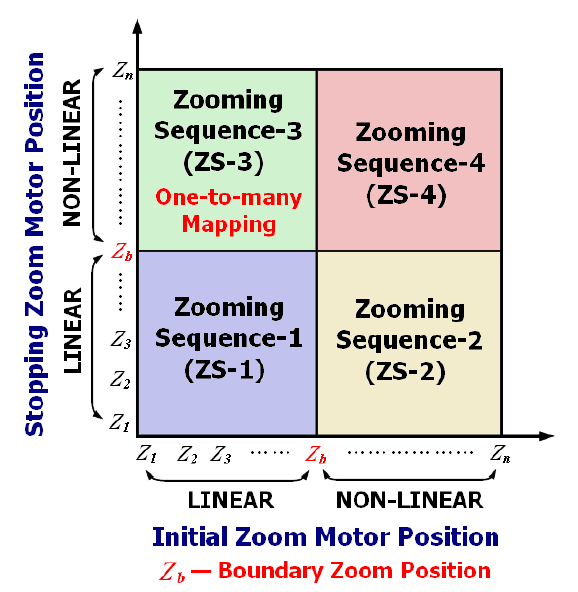
Figure 15. Different types of zooming